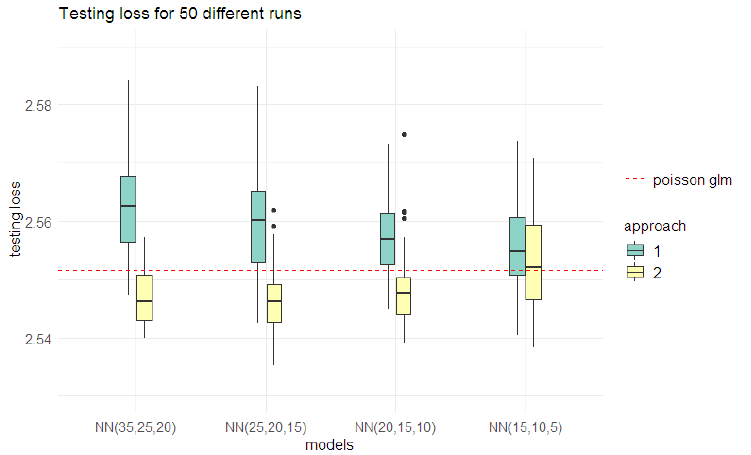
Figure 9. Performance from 50 different calibrations for Poisson NN models under different architec- tures on testing data set, for the best combination of batch sizes and epochs identified in Approach 1 (175,000, 1500) and Approach 2 (30,000, 250). The horizontal red line shows the deviance loss value for the Poisson regression